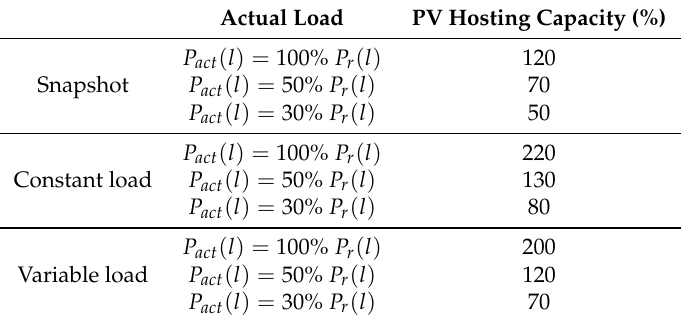
Table 3. PV hosting capacity for different kinds of simulations and percentage of actual